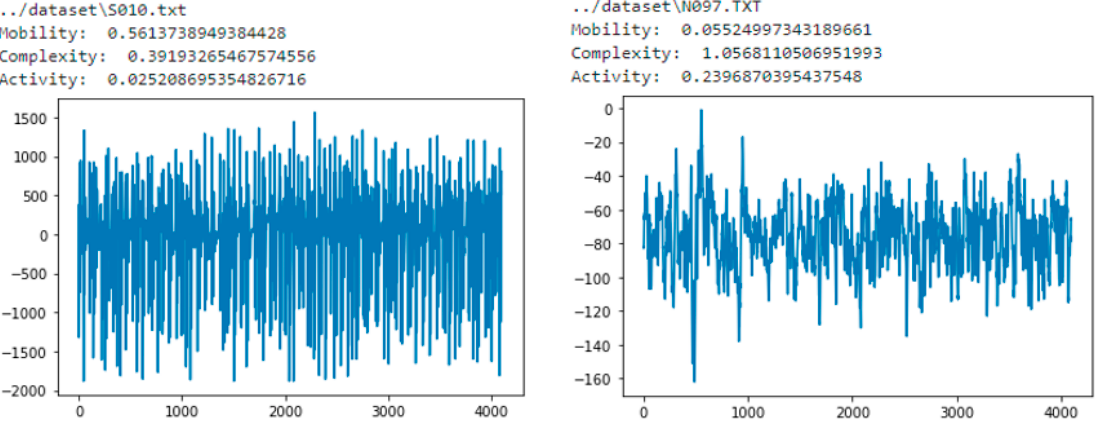
Figure 10. Comparison results for two sample files from two different classes, ictal and interictal. Interictal signals normally have lower mobility but higher complexity values compared to ictal.